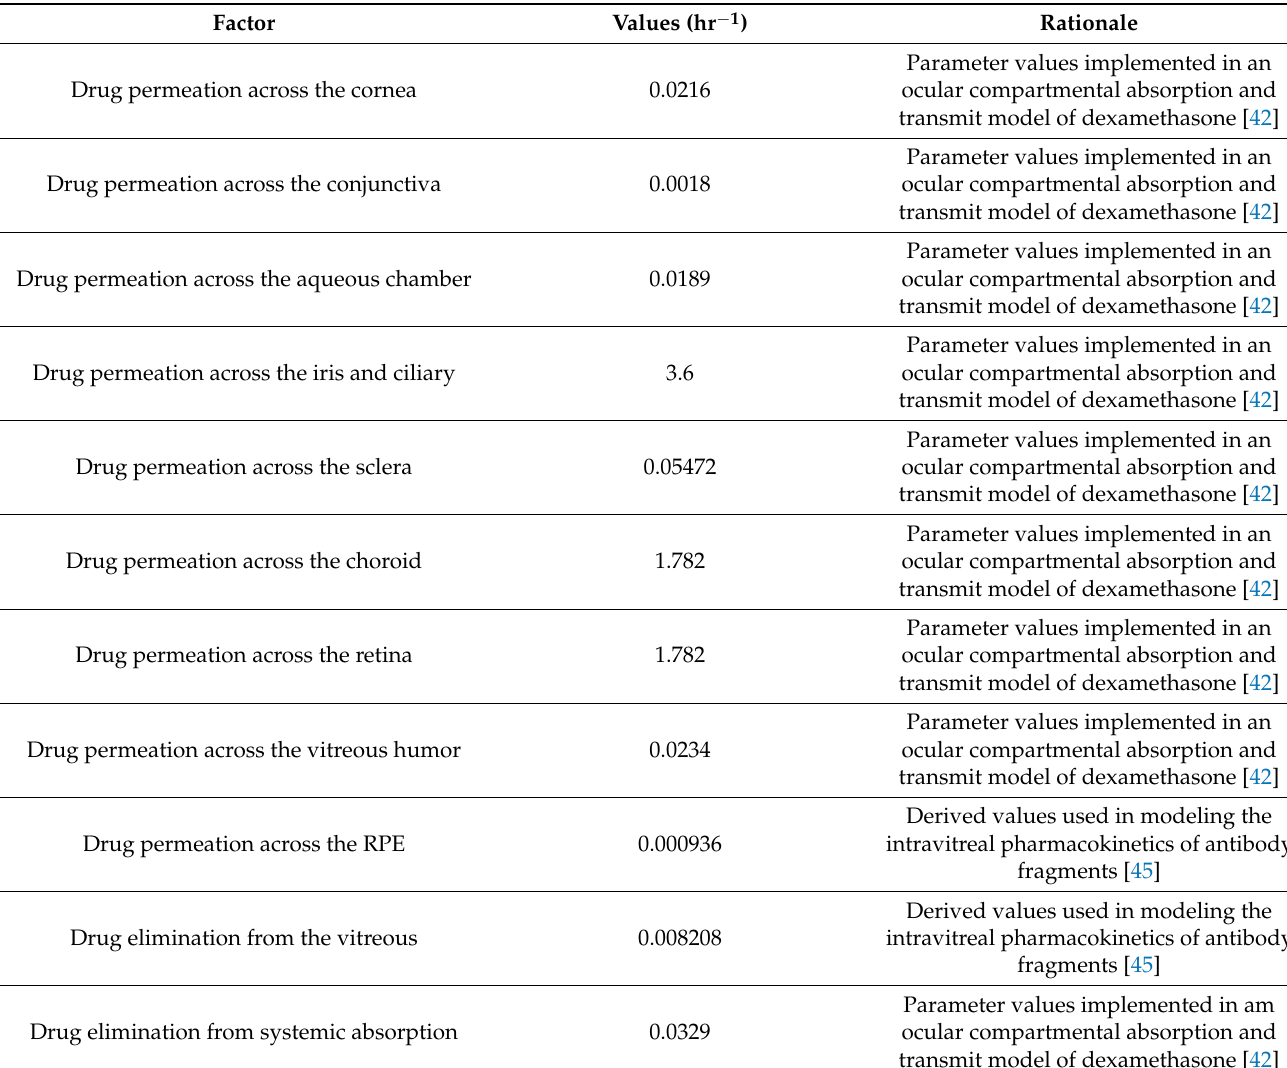
Table 1. The non-zero rate constants selected for the model